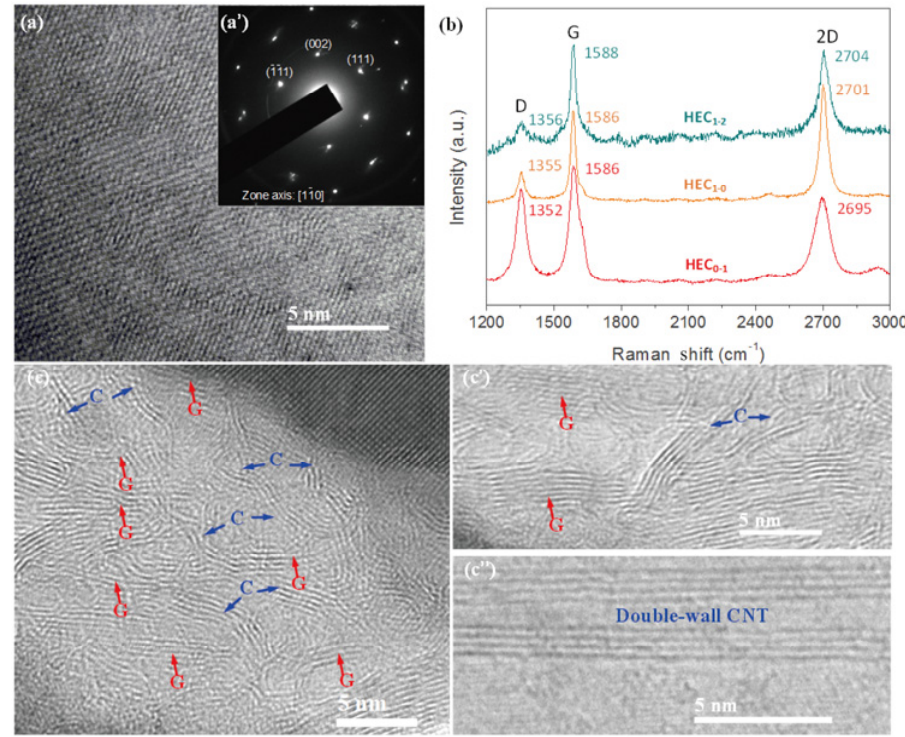
Fig. 2 (a) HRTEM image of HEC 1-2 and (a') corresponding SAED pattern, (b) Raman spectra of HEC nanocomposite samples, and (c, c', c'') HRTEM micrographs of HEC 1-2 showing hybridization of G and CNT.